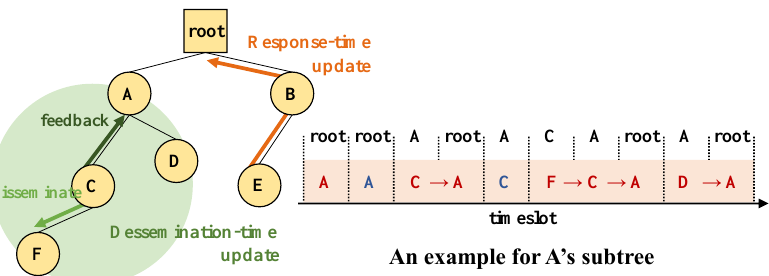
Figure 5. Response and dissemination time